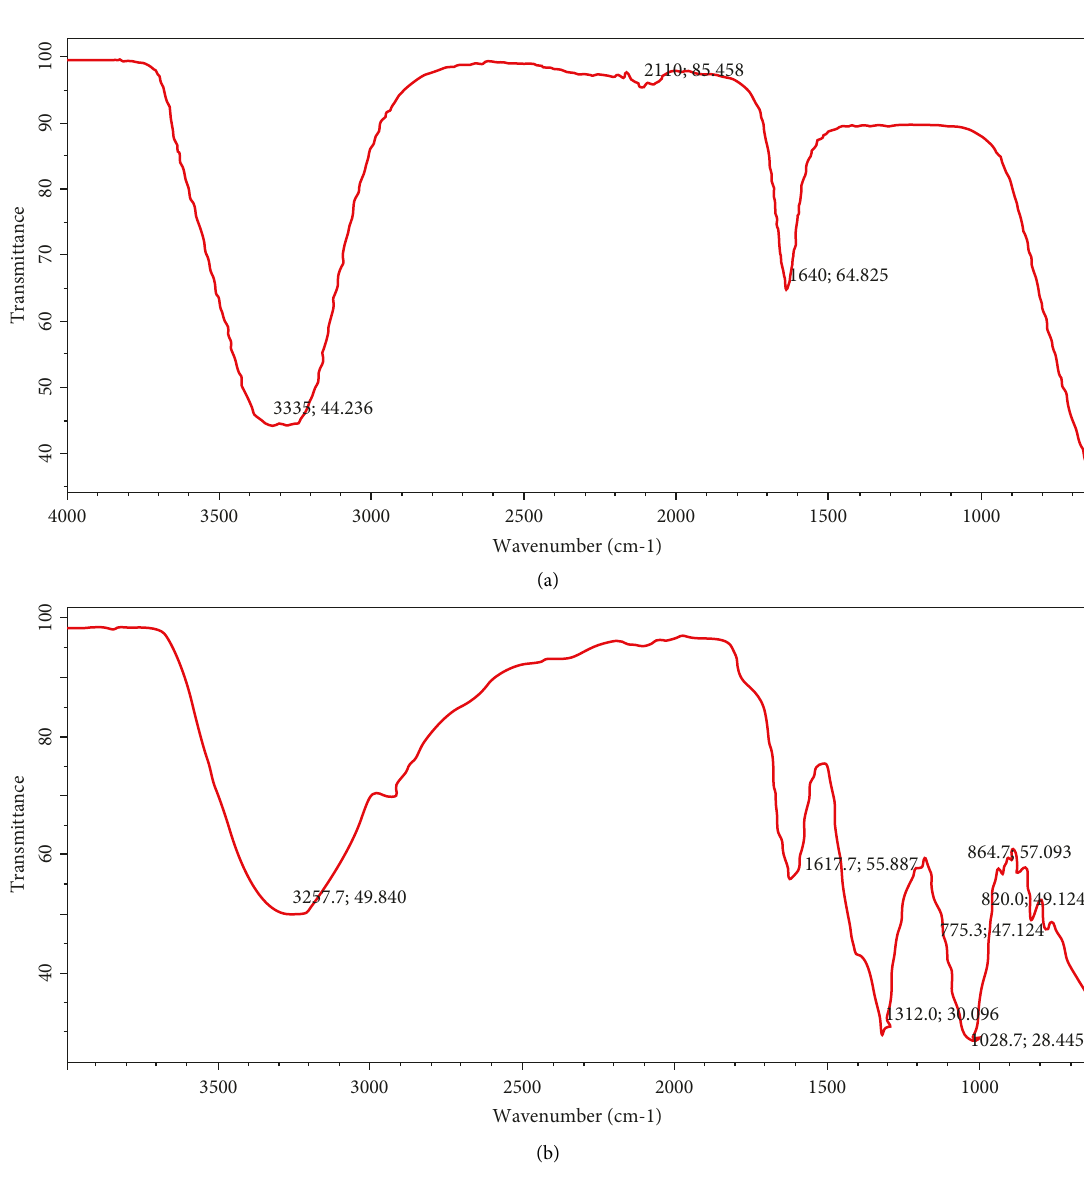
Figure 2: (a) FTIR spectrum of Spinacea oleracea leaf extract. (b) FTIR spectrum of synthesized iron oxide